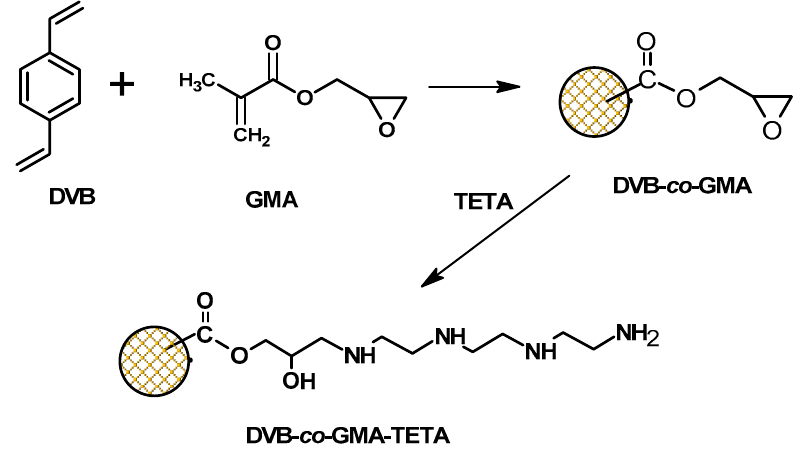
Figure 1. Chemical structure and functionalization of microspheres.